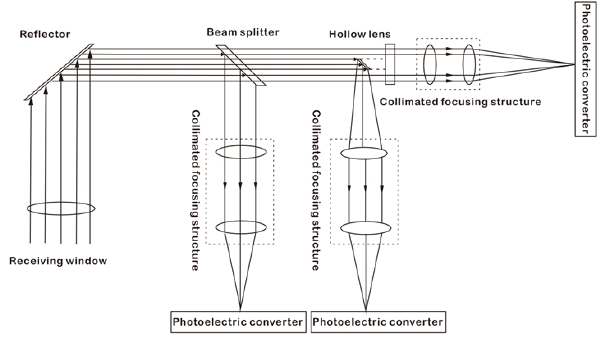
Figure 3. Three-channel structure diagram